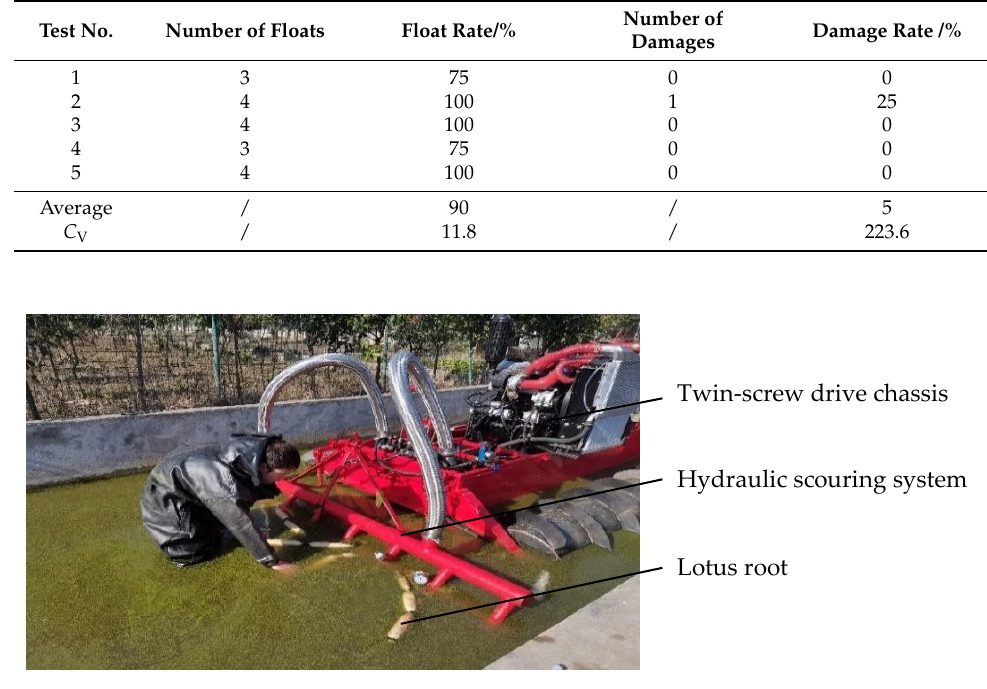
Figure 14. Lotus root harvesting test. Table 12. Test results of lotus root harvesting. Test No.